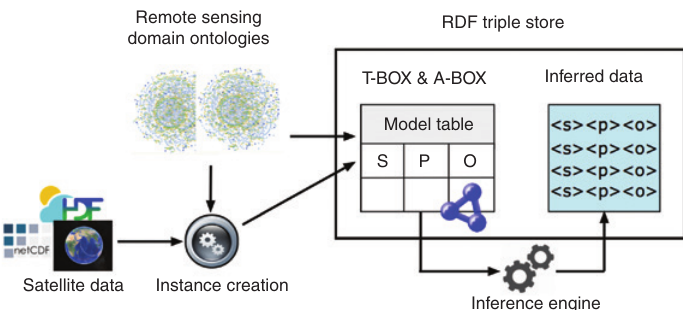
Figure 3: Strategy 1: Ontology Concept-Based Satellite Data Management.